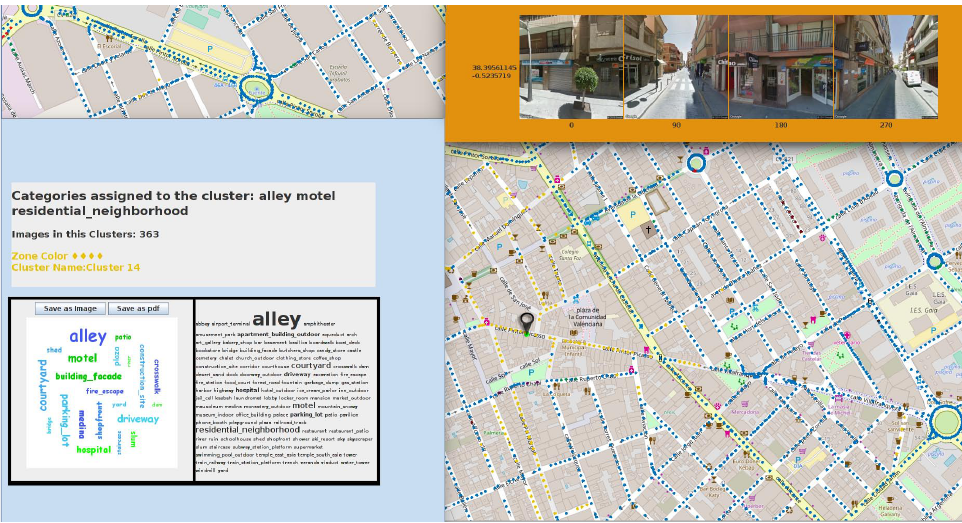
Figure 12. Details of the map generated for a specific point in the